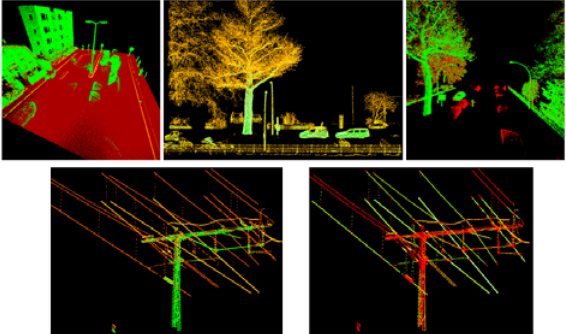
Figure 1 Point feature attributes: height above ground (top left), loneliness (top middle and bottom left), percentage of points from other sensor (top right) and linearity (bottom